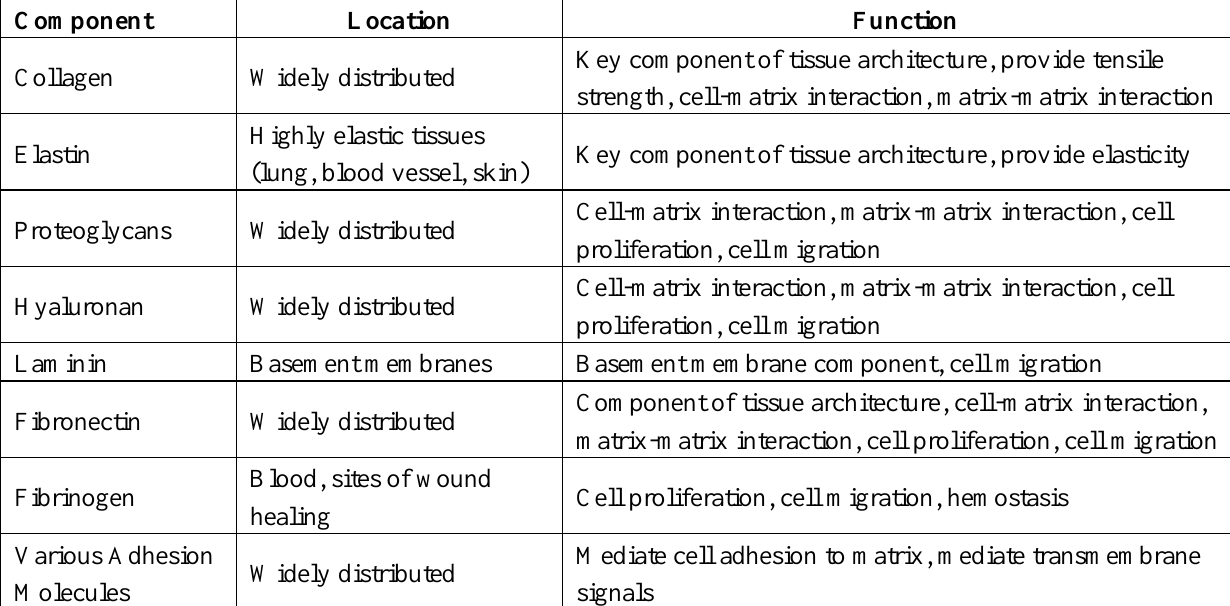
Table 1. Major components of the native ECM, their locations, and functions in the body. Adapted from